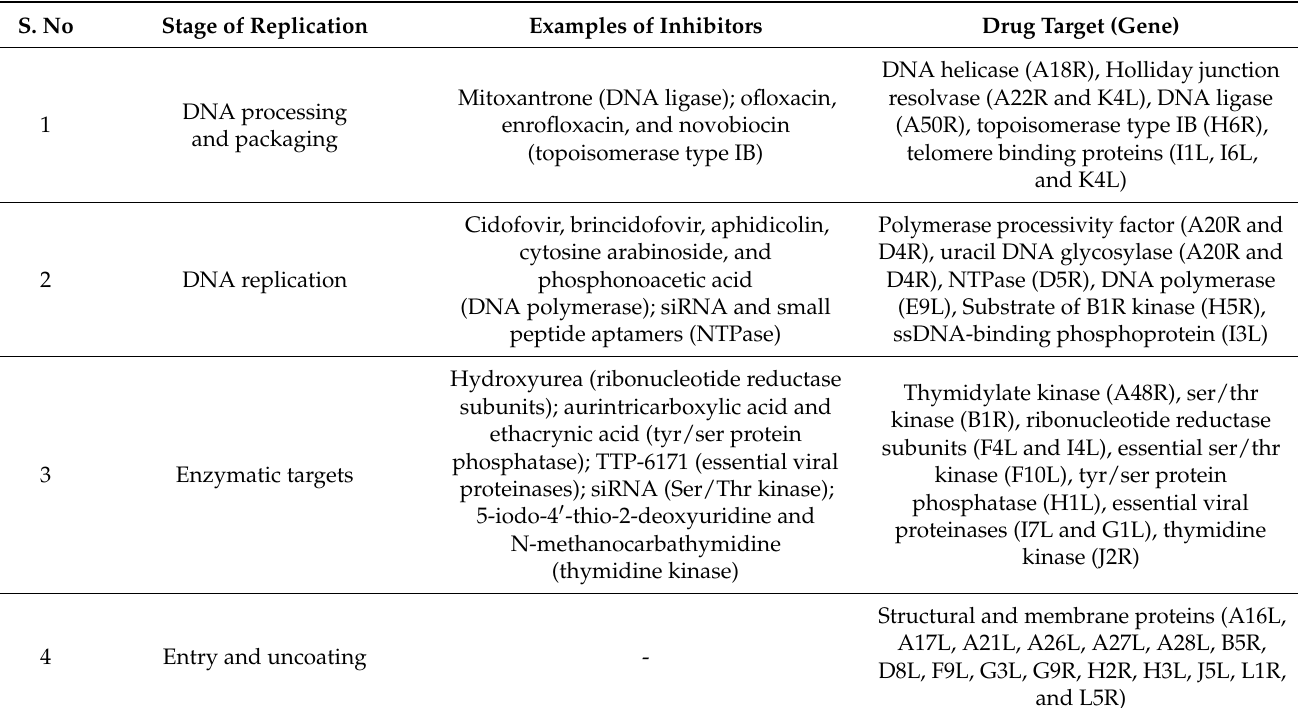
Table 3. Molecular targets for developing anti-OPV drugs